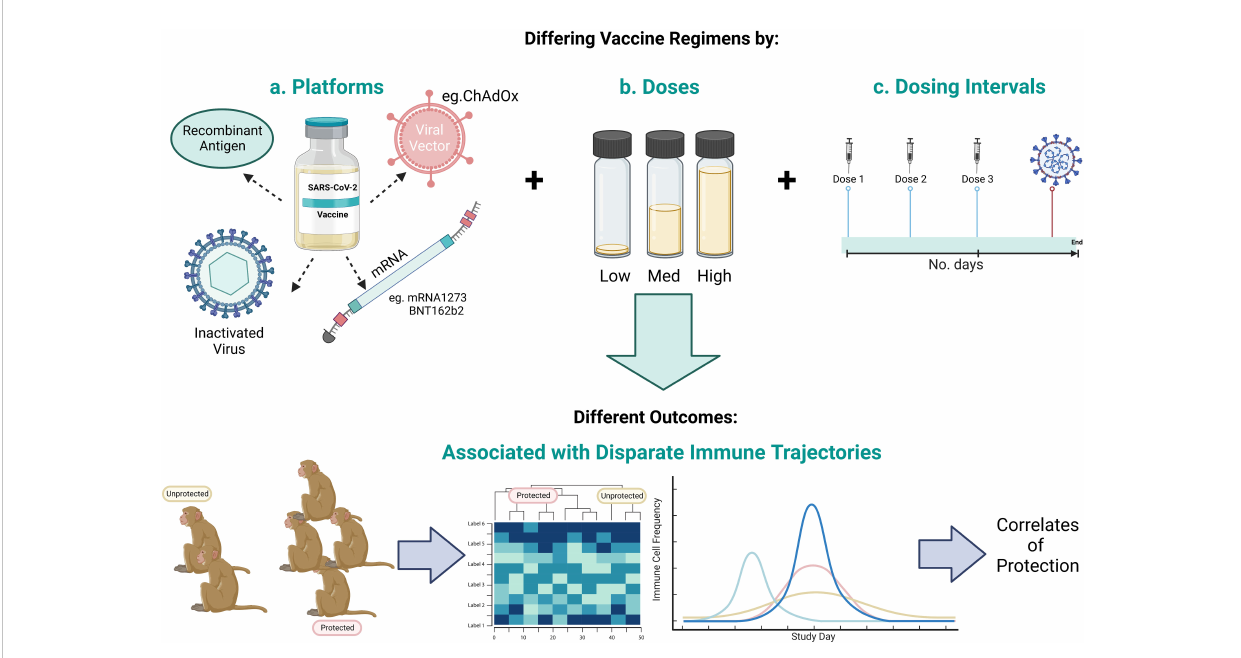
FIGURE 5 Schematic representing the scope to identify CoPs by investigating a range of a) vaccine candidate platforms, b) number of vaccine doses, and c) vaccine dosing regimens to give a range of outcomes in order to identify the immune pro fi le that differentiates protected from unprotected animals. Created with